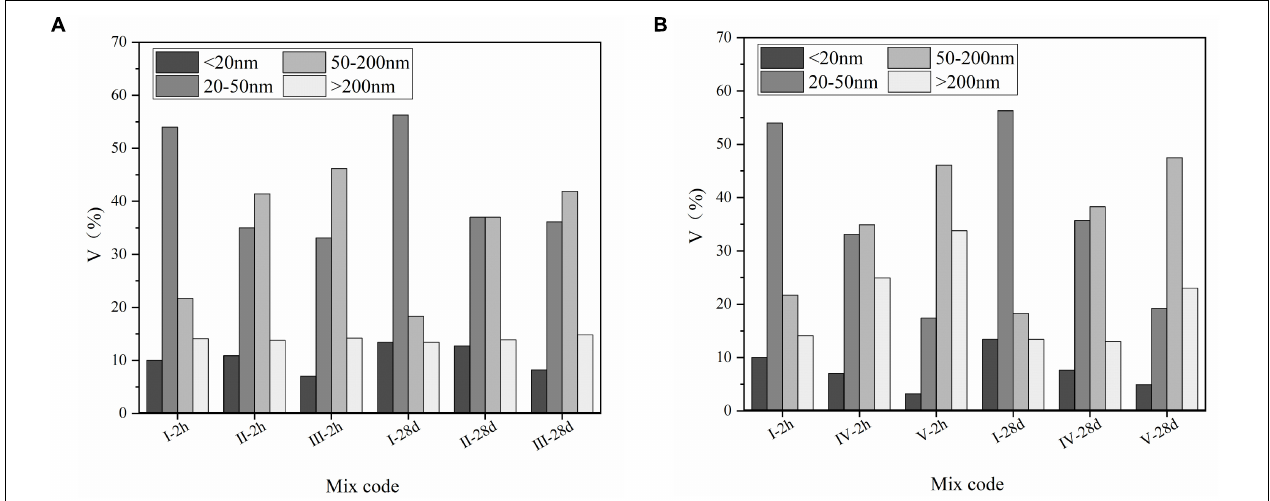
FIGURE 9 | (A) Pore size distribution of the CAEM with various W/C ratios. (B) Pore size distribution of the CAEM with various A/C ratios.